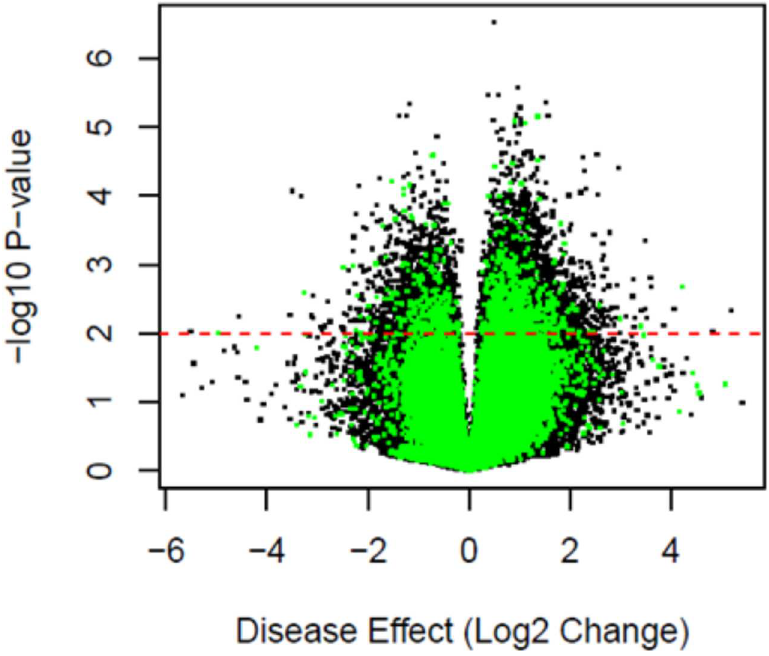
Fig 2. Volcano plot showing statistical significance and fold change effect of individual FECD probes compared to control. The red line indicatesthreshold of significancewhere Q (cid:20) 0.01.